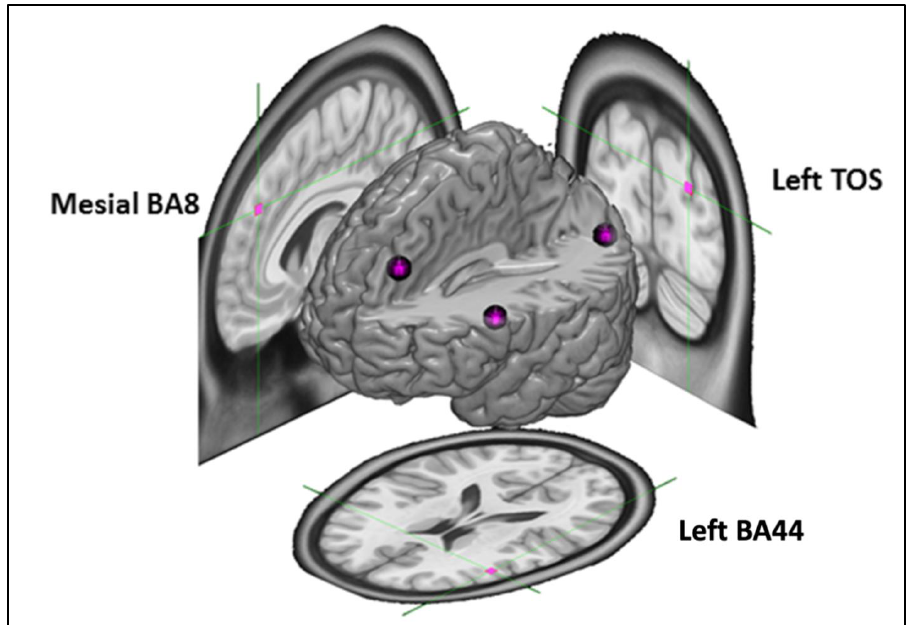
Figure 2 . cTBS target sites: LBA44 in Broca’s area (aimed at the pars opercularis of the inferior frontal gyrus; MNI coordinates: x = −50, y = 18, z = 18 [52]), MBA8 (MNI coord: x = −6, y = 40, z = 38 [39,52]), and LTOS (MNI coord.: x = −25, y = −85, z = 25 [89]).